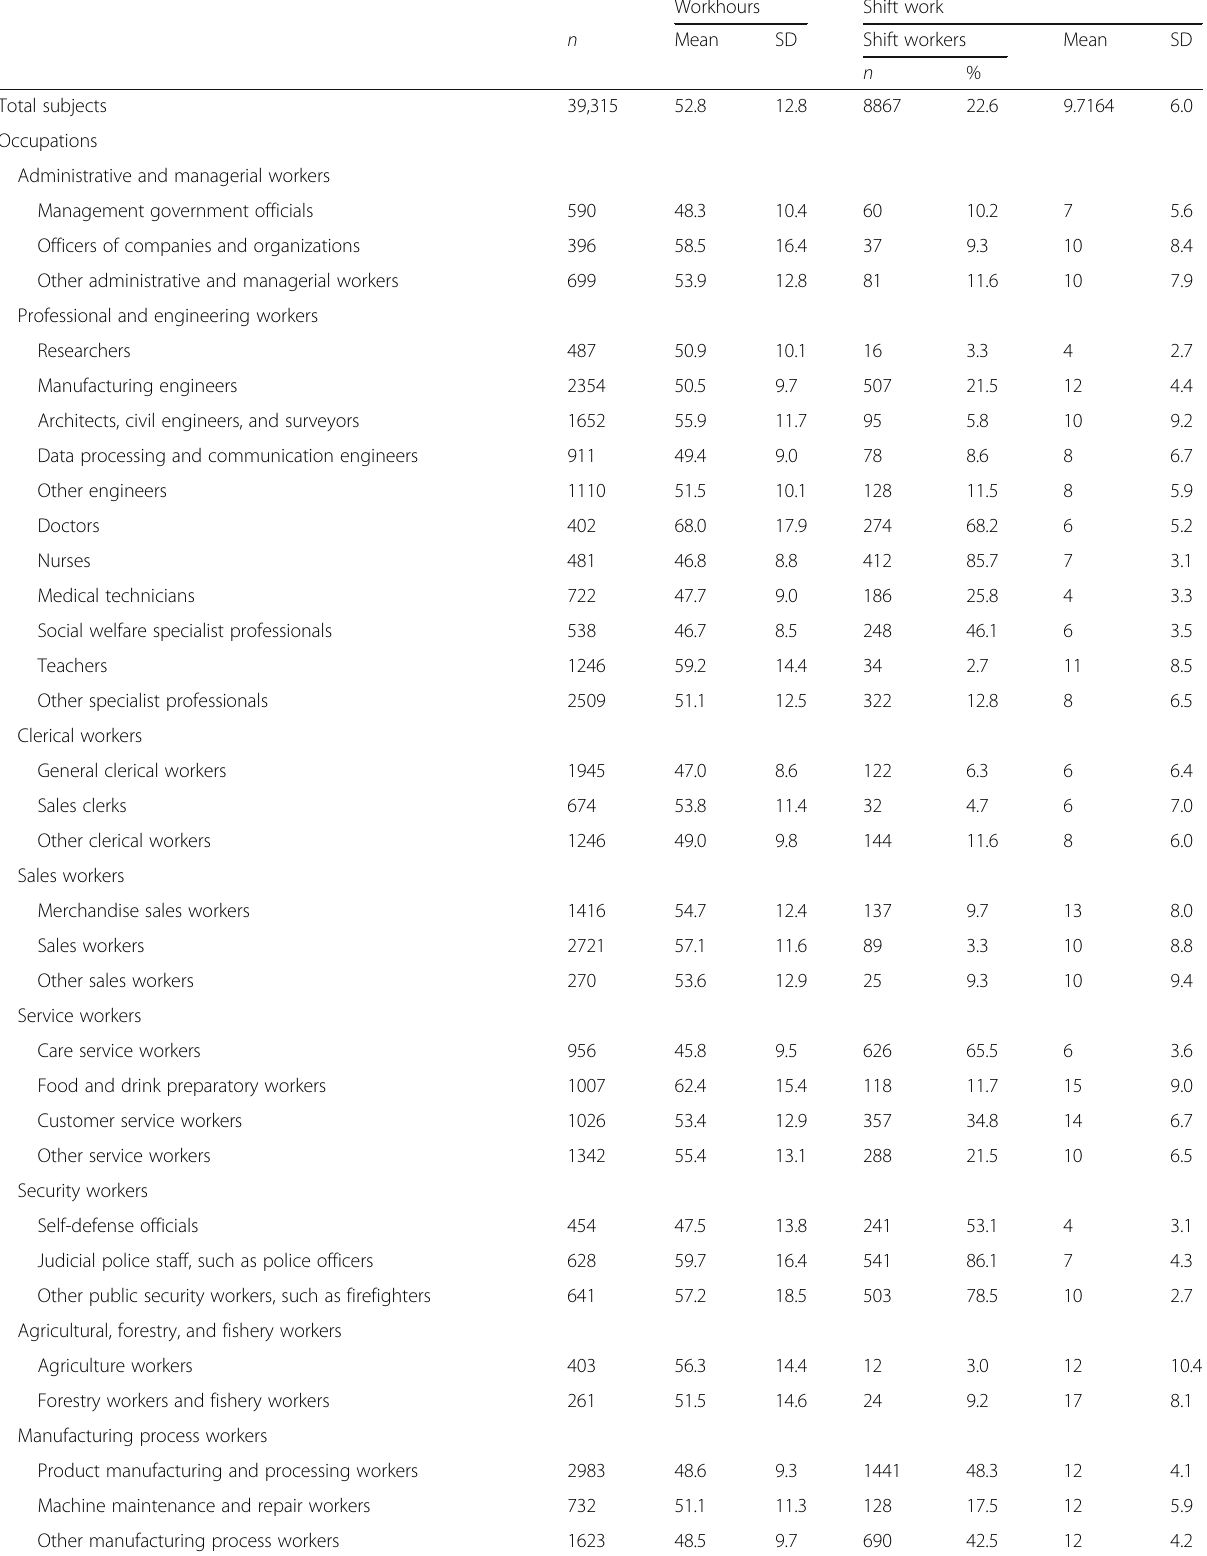
Table 2 Workhours and shift work according to occupations ( N =